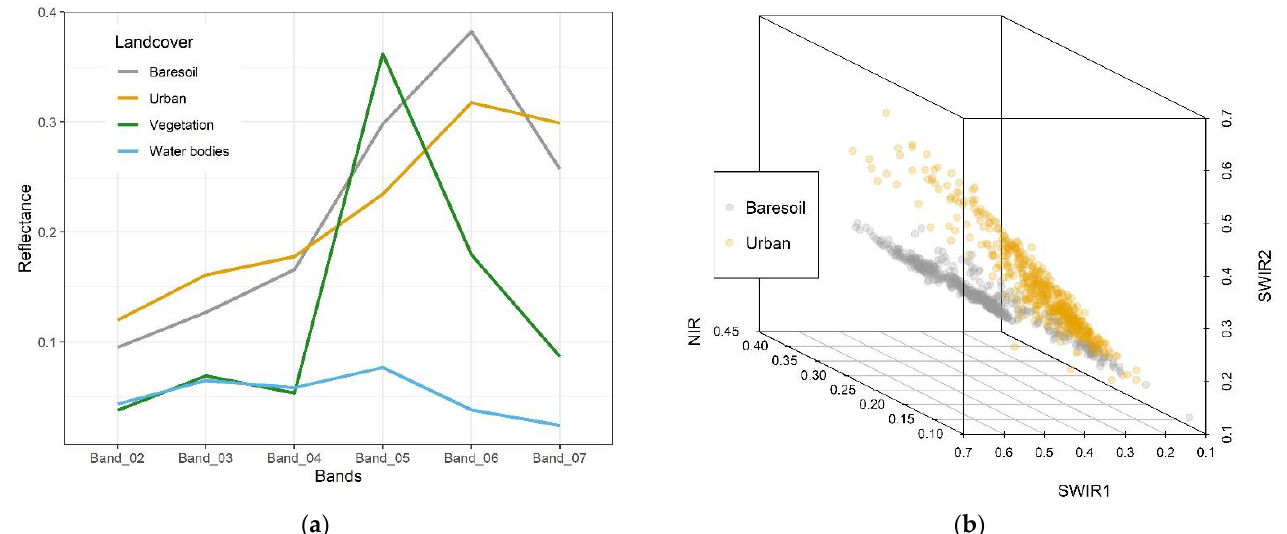
Figure 3. ( a ) Spectral profiles show reflectance properties of different land cover types; ( b ) 3D plot presents spatial separation of bare soil and built-up samples based on reflectance values in NIR, SWIR1, and SWIR2 bands. Orange and gray dots represent bare soil and built-up samples, respectively.